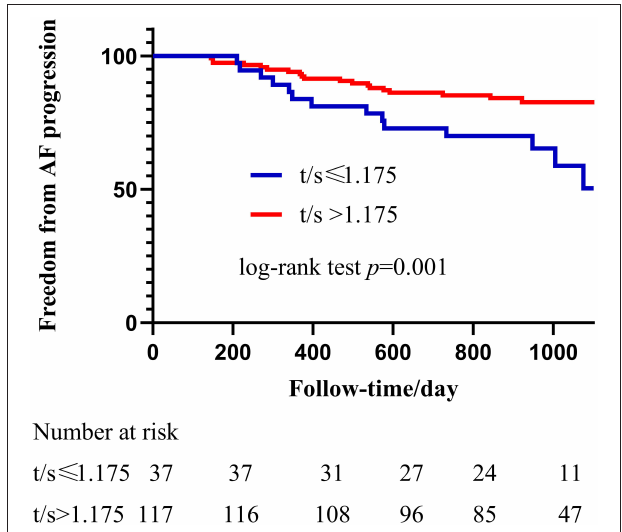
FIGURE 3 | Kaplan-Meier analysis of Shorter LTL in predicting progression from PAF to PsAF after catheter ablation. The blue line represents LTL shorter or equal to 1.175 and the red line represents LTL longer than 1.175. Progression rate in shortened LTL patients was significantly higher than non-shortened, and HR = 2,71 (95% CI: 1.36–5.42, p = 0.005).